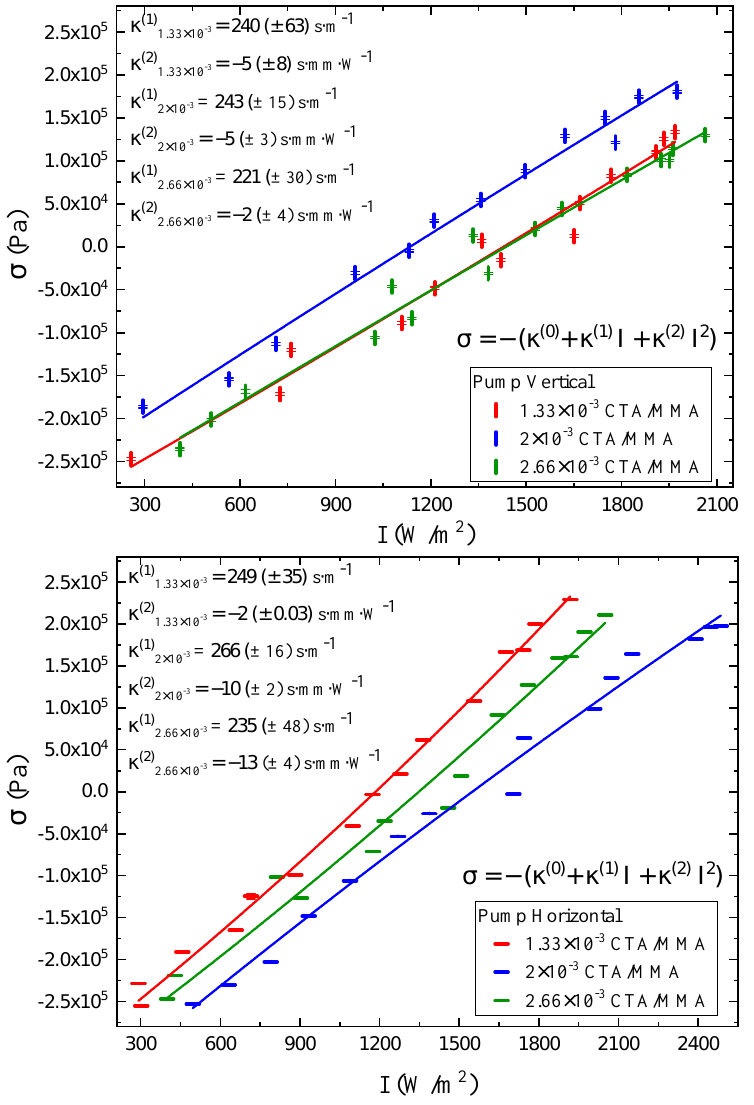
Figure 11. Polarization-dependent steady-state stress response at long times as a function of pump intensity at a pump wavelength of 488nmfor different CTA volume fractions. The pump light is polarized parallel to the fiber’s long axis ( top ) and perpendicular to the fiber axis ( bottom